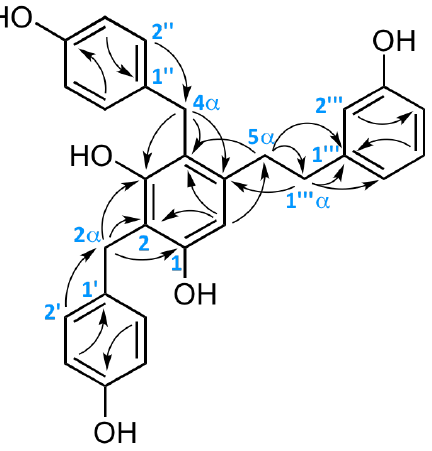
Figure 2. Essential HMBC correlations of bletistrin G ( 2 ).